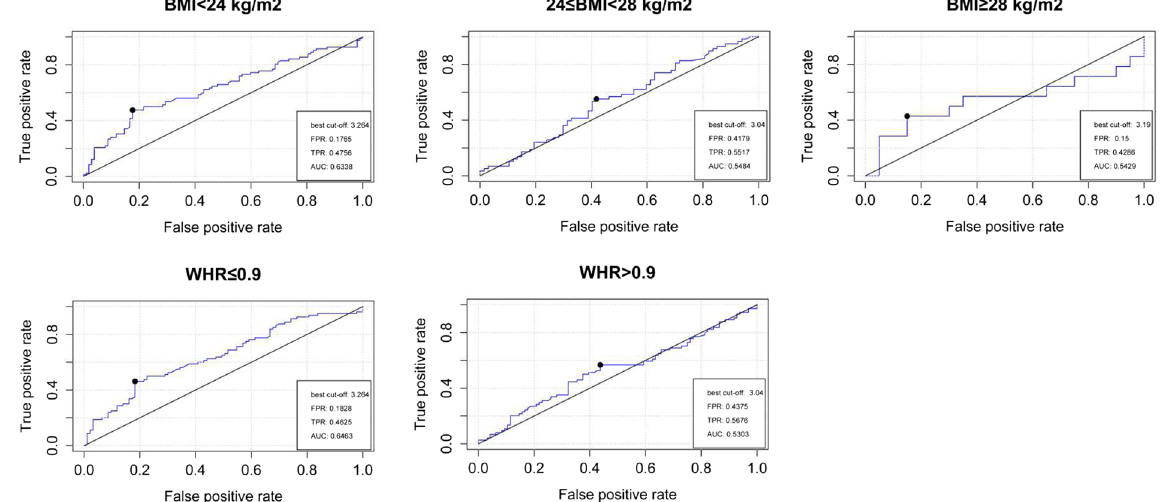
Figure 3. Relative operating characteristic (ROC) curve analyses of osteocalcin in predicting the ED risk for the obesity assessed by BMI and WHR. The Best cut-off, area under the curve (AUC), False Positive Rate (FPR) and True Positive Rate (TPR) are shown in the